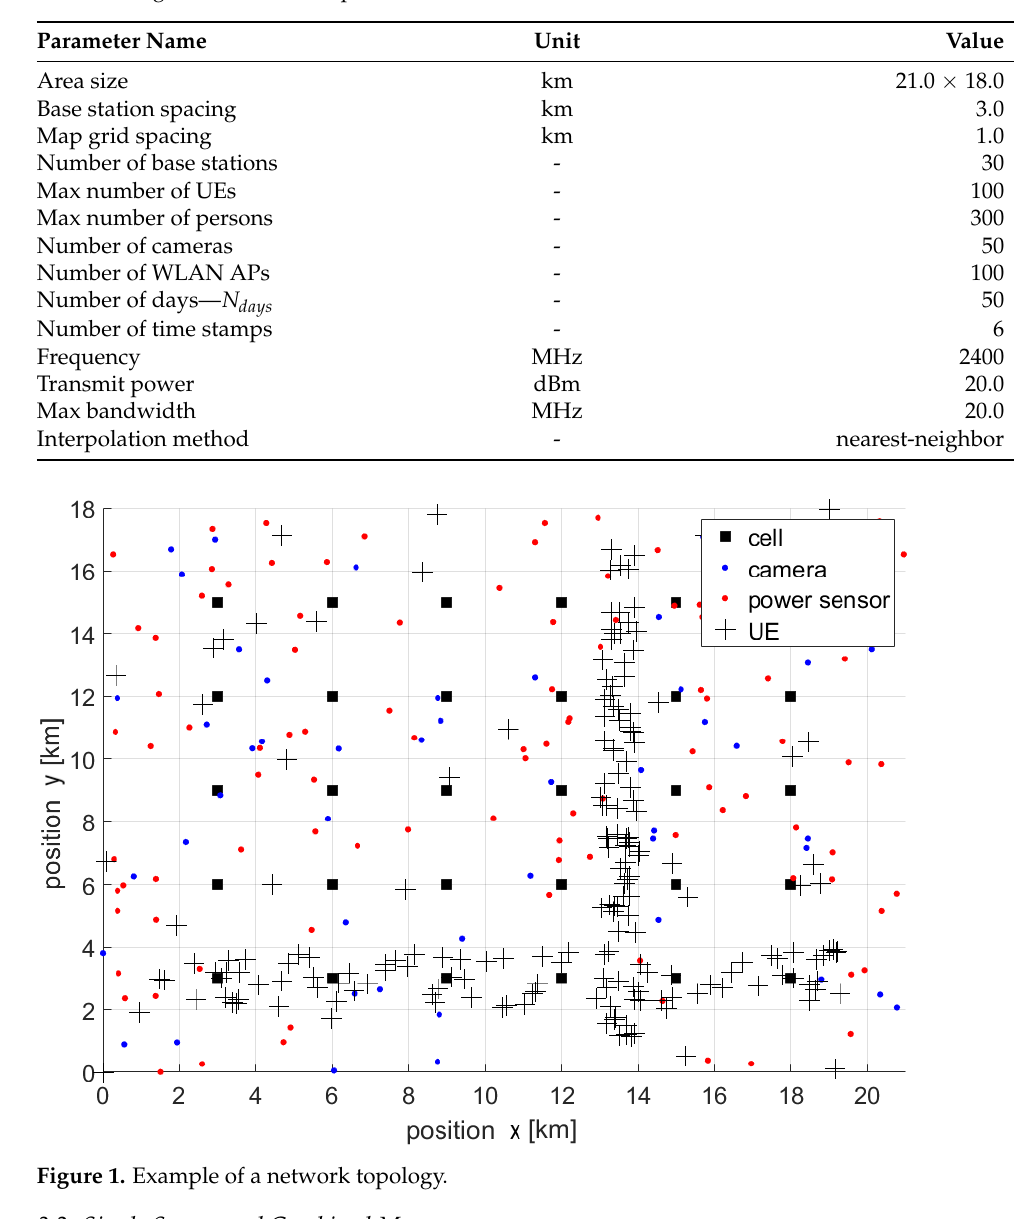
Table 1. Single simulation run parameters.